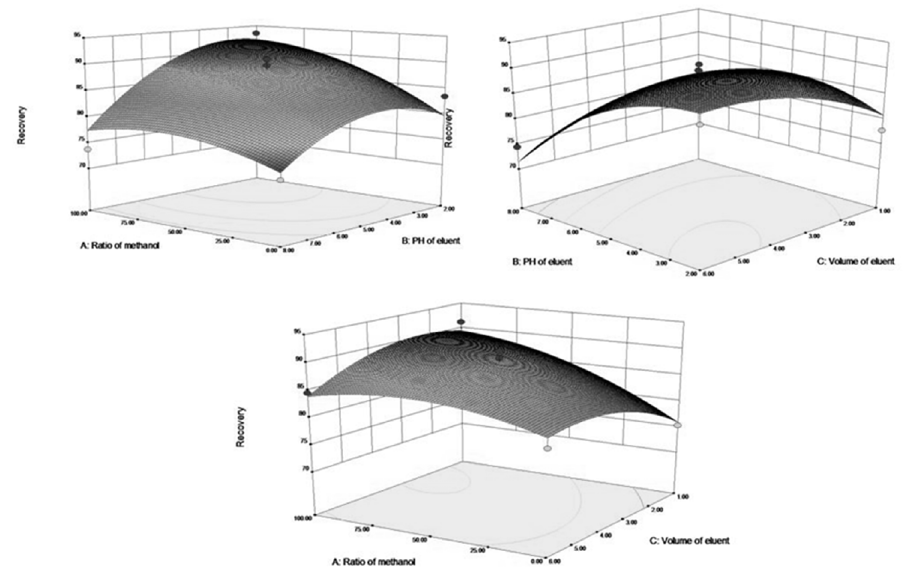
Figure 8. Effects of ratio of metanol, PH of eluent, volume ofeluent, and their reciprocal 3D response interaction on recoveries for Theophlline with DES-7-Fe 3 O 4 /MIPs in SPE.